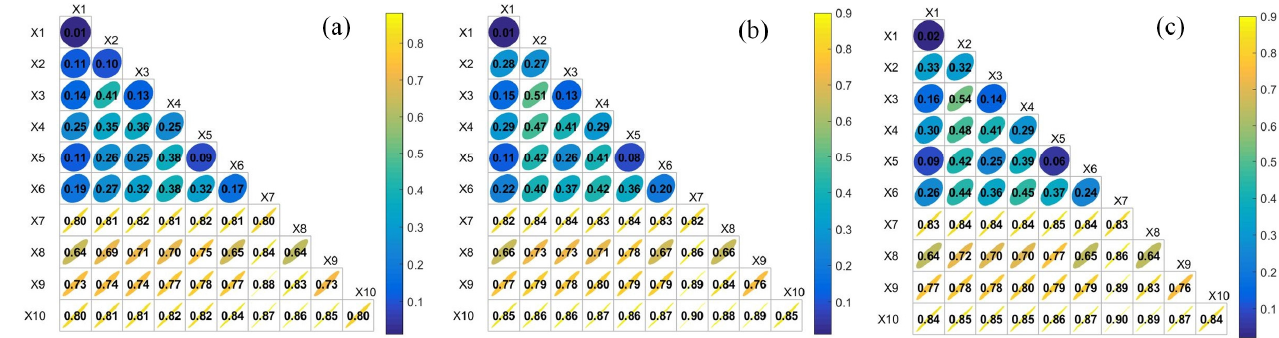
Figure 10. Interaction detection in ( a ) 2000, ( b )2010 and ( c ) 2020 of impact factors.